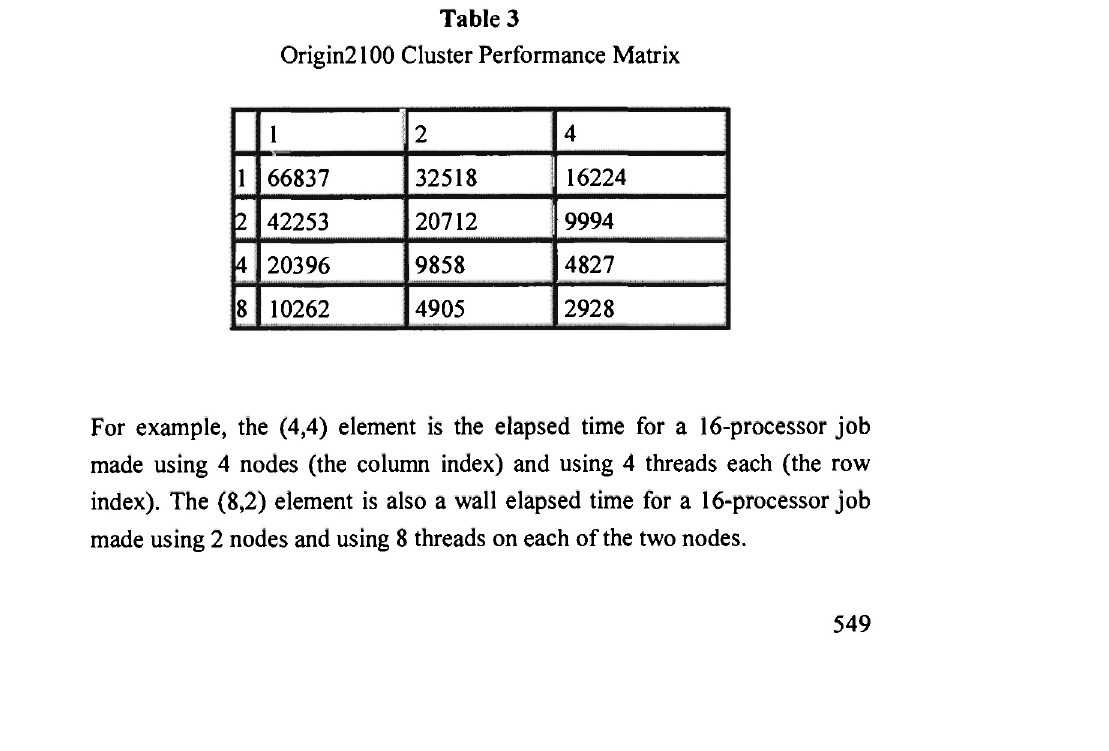
Table 3 defines a Cluster Performance Matrix for an Origin2100